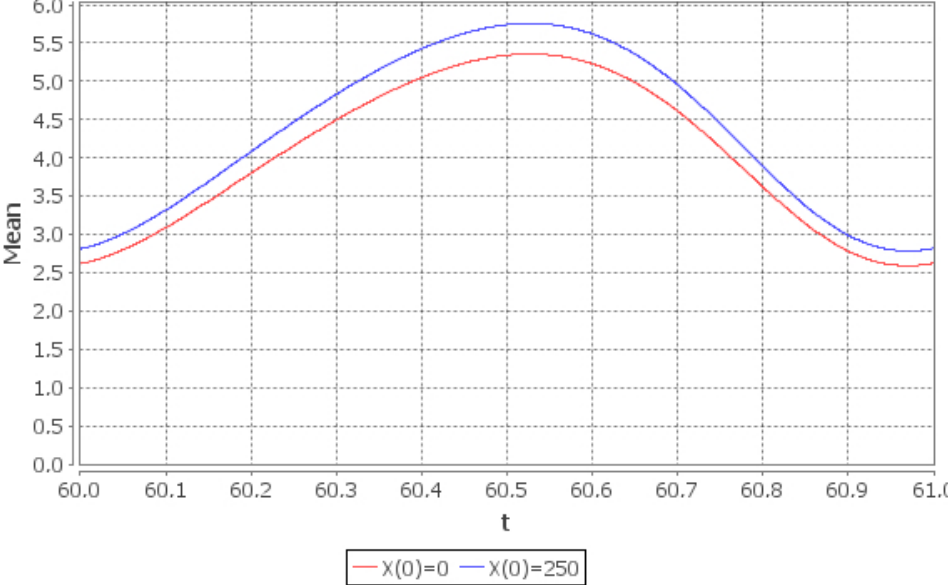
Figure 8. Limiting conditional mean E ( t , k ) number of customers in the system: E ( t ,0 ) ( red line ), E ( t ,250 ) ( blue line